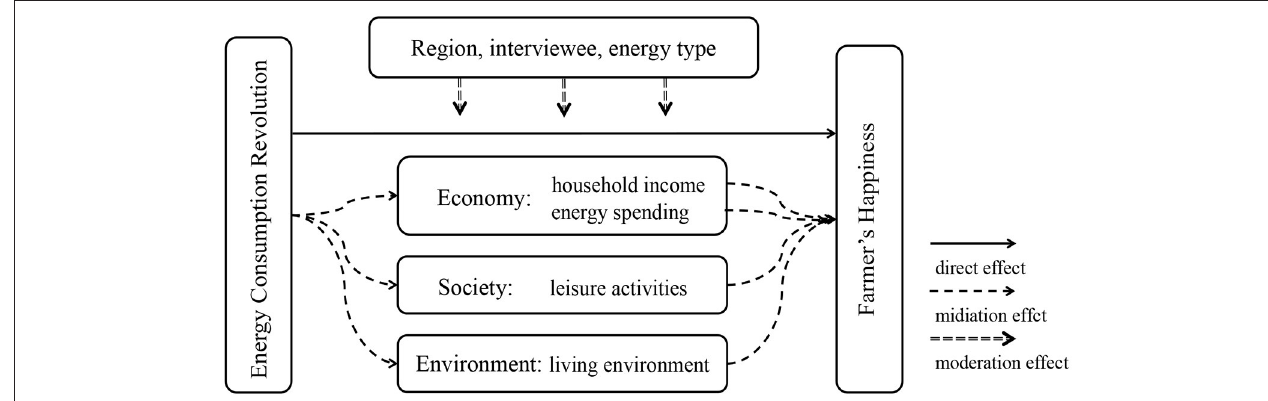
FIGURE 1 | The mechanism of energy consumption revolution effect on farmers’